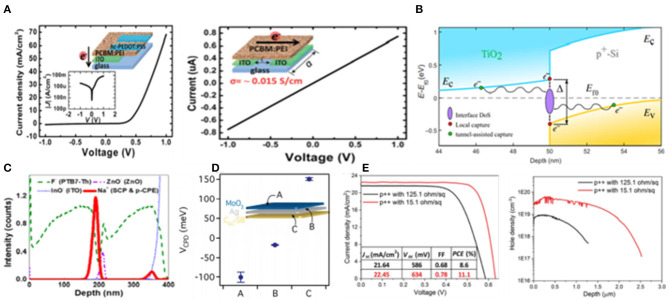
(A) J–V characteristics of the devices including the current flows vertically across the film and the current flows in parallel with the substrate (reproduced from ref. 74, copyright 2016, The Royal Society of Chemistry). (B) Contact behavior and simulated band diagram of TiO2/p+ -Si interfaces (reproduced from ref. 76, copyright 2018, Science Advances). (C) TOF-SIMS depth profile of the ITO/p-CPE:BHJ/ZnO/SCP/p−CPE:BHJ structure (reproduced from ref. 58, copyright 2016, ACS). (D) Surface potential (VCPD) of the recombination layers [C60-SB (30 nm)/Ultrathin Ag (10 nm)/MoO3 (10 nm)] (reproduced from ref. 75, copyright 2016, ACS). (E) J–V curves and electrochemical capacitance–voltage measurements of Si bottom cells that have different p++ emitter profiles (black for 125.1 ohm sq−1 and red for 15.1 ohm sq−1 (reproduced from ref. 78, copyright 2018, The Royal Society of Chemistry).